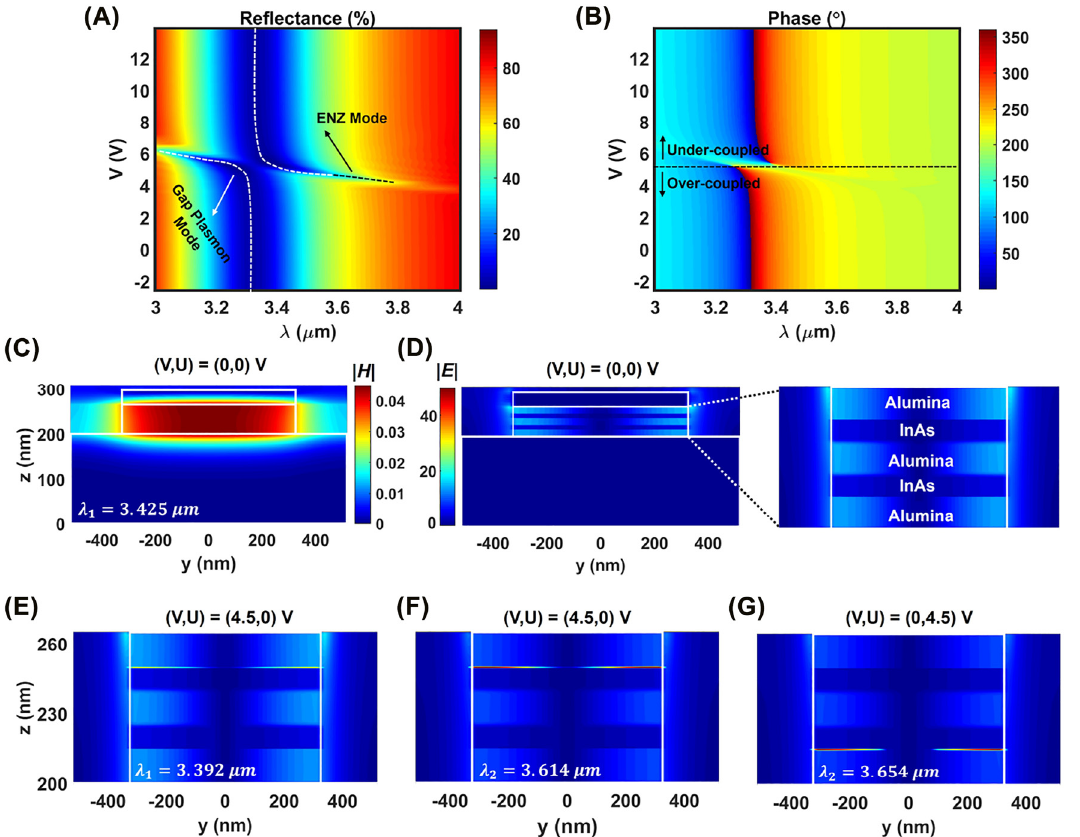
Figure 3: Spectral response of the under-biased metasurface and the near-field distribution. (A) Reflectance and (B) phase distributions of the reflected light as functions of the incident wavelength and applied bias voltage. The spectral overlap between two modes is observed around the operating wavelength of ≈ 3 . 38 μ m. The dashed lines in (A) and (B) respectively mark the spectral position of the resonances that shift to shorter wavelengths by increasing the bias voltage and the applied bias voltage corresponding to the critical coupling point between over-coupled and under-coupled resonant regime. Distributions of the total (C) magnetic and (D) electric fields within the nanoantenna heterostructure at no-bias at the wavelength of 3.425 μ m. The right figure of (D) represents the zoomed-in image of electric field inside the alumina/InAs/alumina/InAs/alumina stack. Electric field distribution within the alumina/InAs/alumina/InAs/alumina stack of nanoantenna heterostructure for wavelength and bias voltage combinations of (E) 𝜆 = 3.392 μ m, ( V , U ) = (4.5 , 0) V, (F) 𝜆 = 3.614 μ m, ( V , U ) = (4.5 , 0) V, and (G) 𝜆 = 3.654 μ m, ( V , U ) = (0 , 4.5)